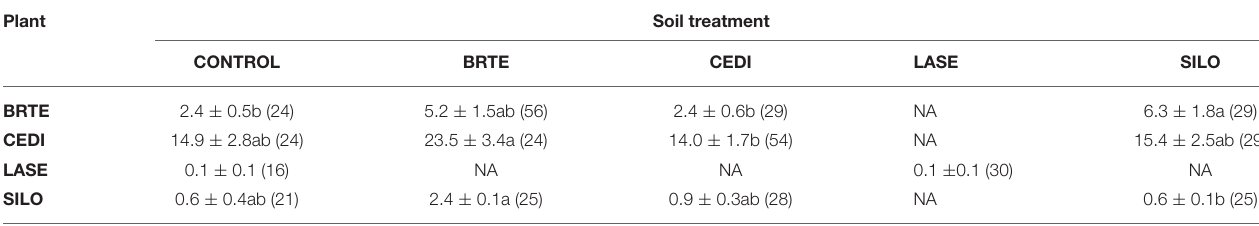
TABLE 3 | Ground cover (%) of four non-native plants on different soil treatments. Plant Soil treatment